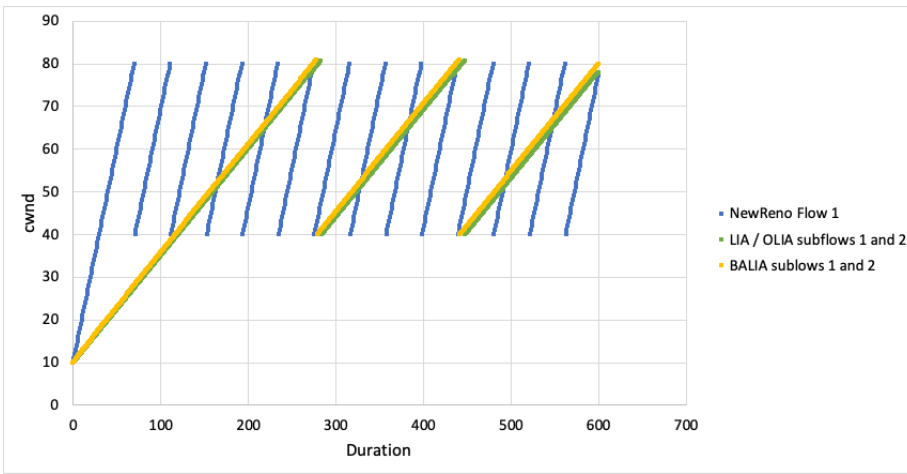
Figure 6. Window growth-Same